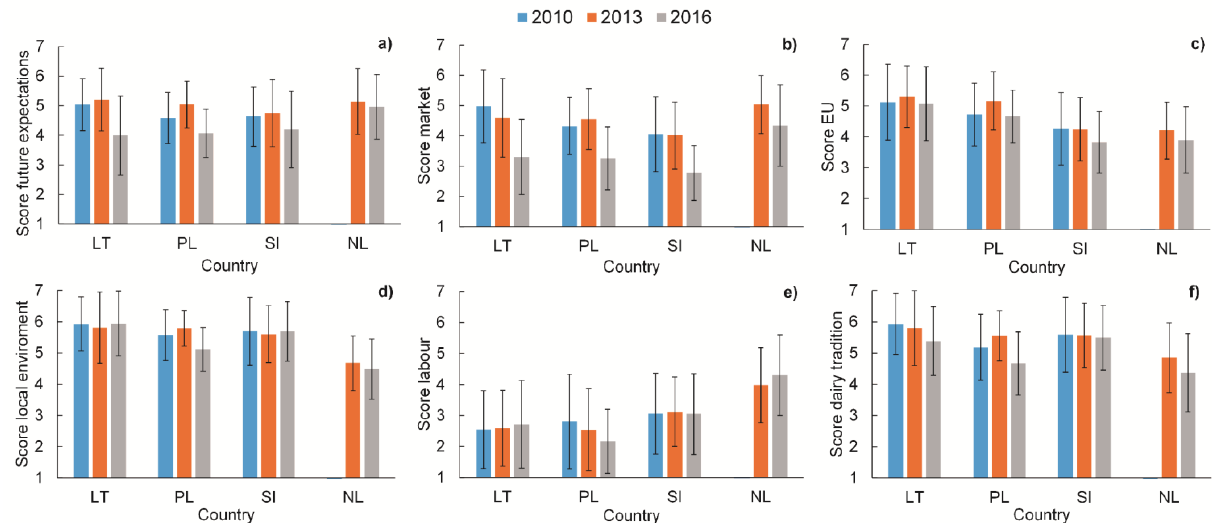
Figure 4. Trend in ( a ) future expectations, ( b ) market, ( c ) EU, ( d ) local rural environment, ( e ) labour and ( f ) tradition for farmers’ groups in four countries in period 2011 to 2016 (1 = pessimistic/negative to 7 = optimistic/positive).